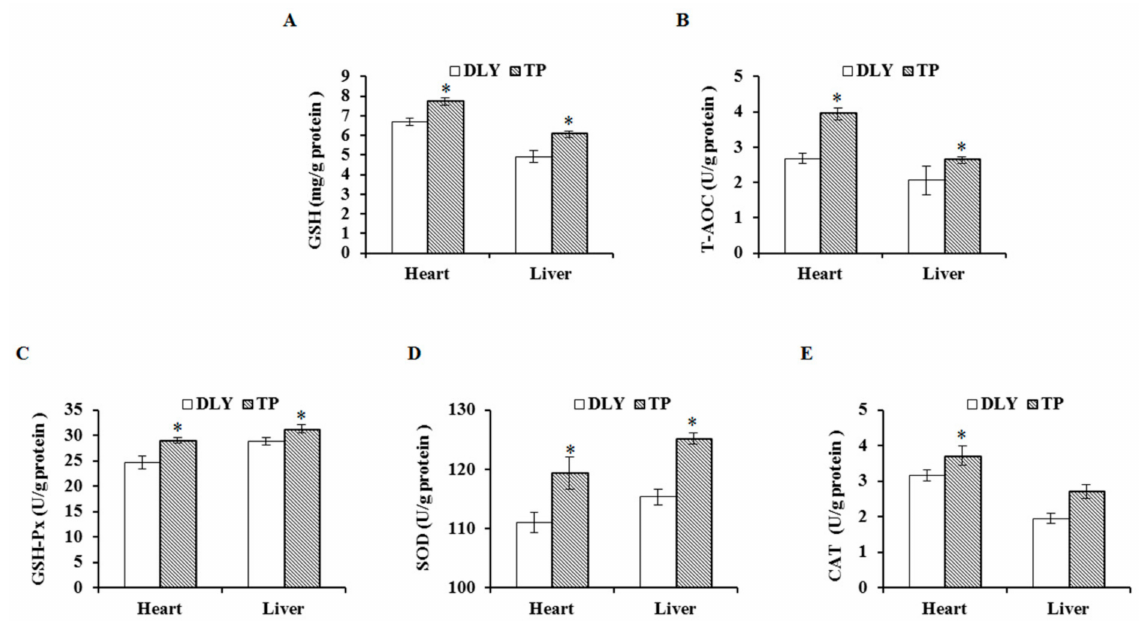
Figure 2. Effects of the plateau environment on GSH ( A ), T-AOC ( B ), GSH-Px ( C ), SOD ( D ), and CAT ( E ) in heart and liver of TPs and DLY pigs ( n = 12). * Significant difference ( p < 0.05). GSH = glutathione; T-AOC = total antioxidant capacity; GSH-Px = glutathione perox- idase; SOD = superoxide dismutase; CAT =